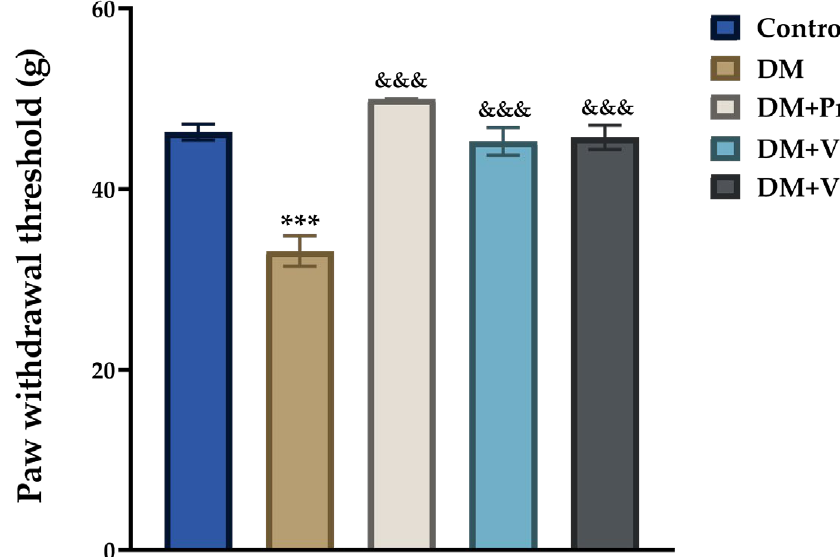
Figure 5. Paw withdrawal thresholds of normoglycemic rats administered with saline solution (control) and diabetic rats administered with saline (DM), 10 mg/kg pregabalin (DM + Pregabalin), 5 mg/kg vortioxetine (DM + Vort 5) or 10 mg/kg vortioxetine (DM + Vort 10) in the Dynamic plantar test. Values are given as mean ± S.E.M. Significant difference against control group *** p < 0.001; significant difference against DM group &&& p < 0.001. One-way ANOVA, post hoc Tukey’s HSD multiple comparison test, n = 8.